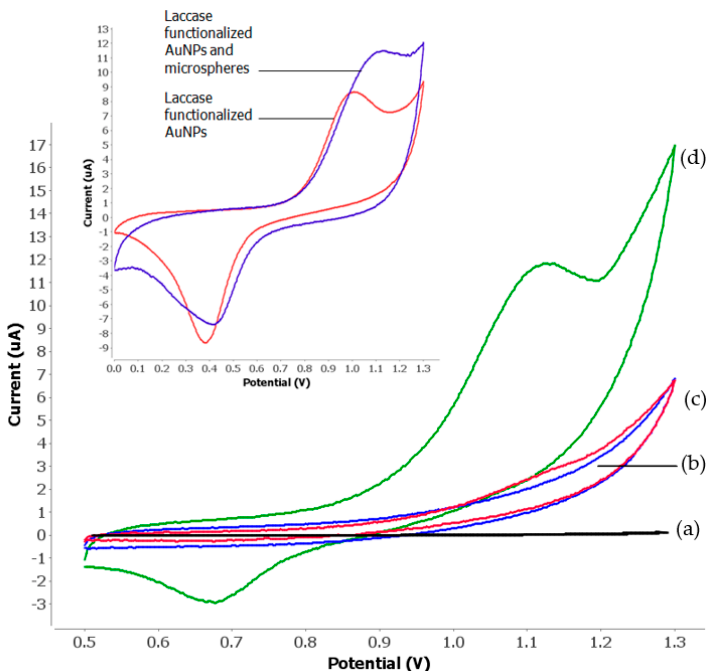
Figure 1. Cyclic voltammograms of (a) bare SPE, (b) Laccase/SPE, (c) microspheres-laccase/SPE and (d) microspheres-laccase/AuNPs/SPE in the presence of 0.5 μ M Tartrazine in 0.1 M PBS pH 5.0. Scan rate: 0.07 V/s. A magnified view of the comparison between AuNP-only (red) and AuNP/microspheres (blue) electrodes voltammogram is shown at the inset.